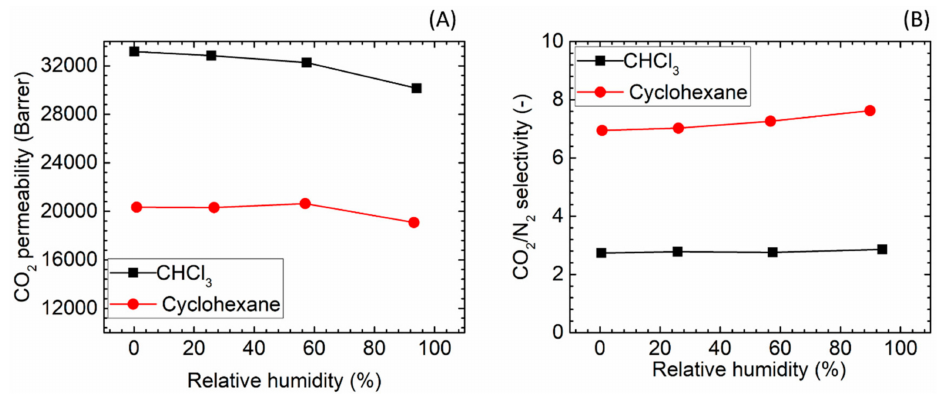
Figure 8. Gas separation performances of PTMSP membrane prepared from two different solvents, ( A ) CO 2 permeability and ( B ) CO 2 /N 2